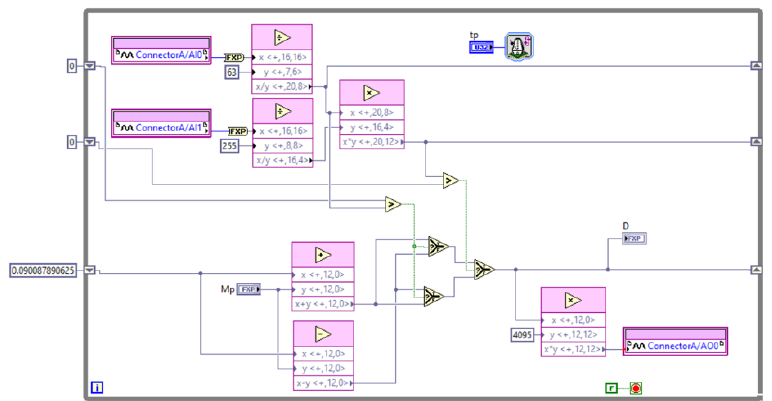
Figure 15. Implementation of the P&O control system emulator (CSE).